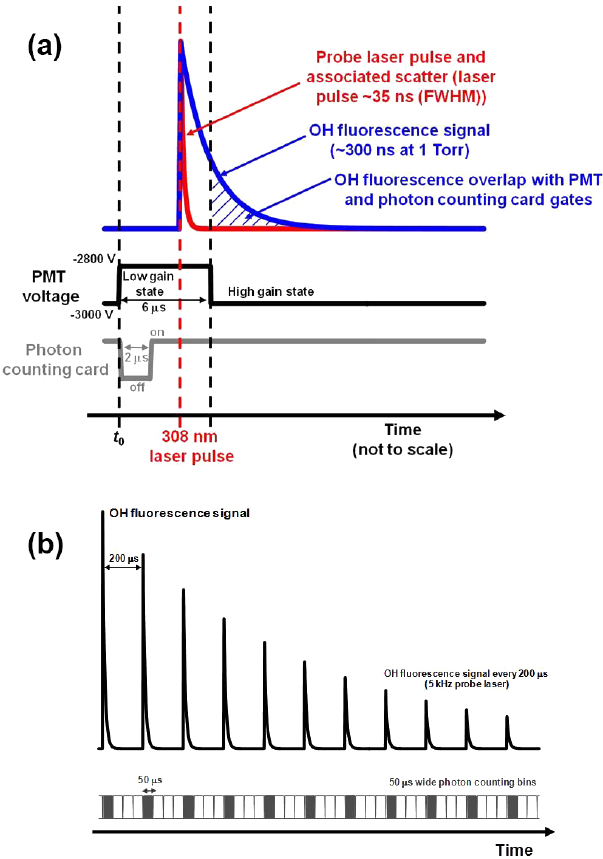
Figure 2. (a) Schematic to illustrate the Stanford Research Sys- tems delay generator controlled gate timing of the PMT detector and photon counting card in the OH reactivity instrument. The blue hatched region indicates the overlap between the OH fluorescence signal and the photon counting gates; (b) Schematic to illustrate the photon counting bin structure used to collect OH fluorescence photons after each 308nm probe laser pulse (5kHz pulse repetition frequency). Four 50µs wide photon counting bins cover the time pe- riod between each 308nm laser pulse, but only the bins immediately after the laser pulse collect any fluorescence photons (shaded bins), and only the photon counts from these bins are used to construct the OH